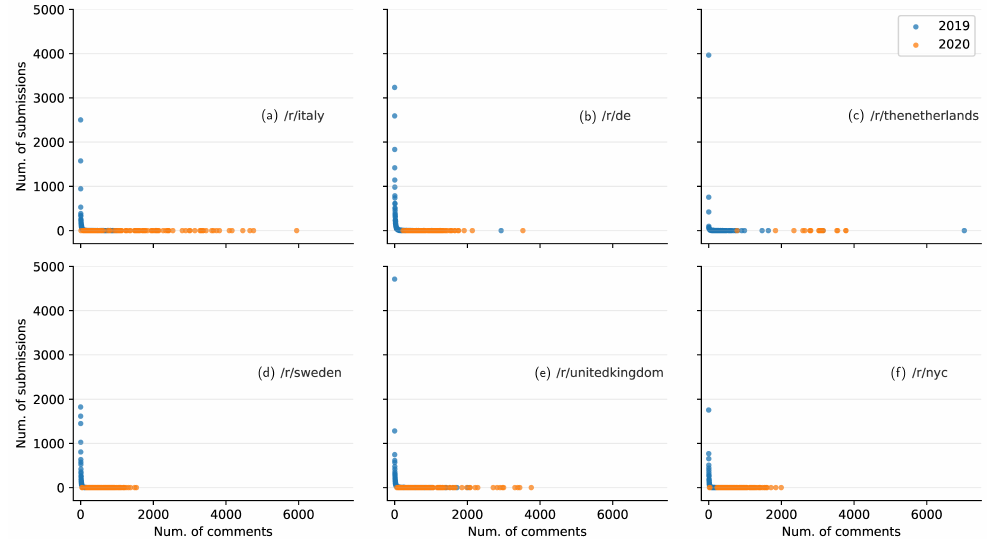
Figure 4. Distribution of submissions against comments per subreddit: ( a ) /r/italy, ( b ) /r/de, ( c ) /r/thenetherlands, ( d ) /r/sweden, ( e ) /r/unitedkingdom and ( f ) /r/nyc